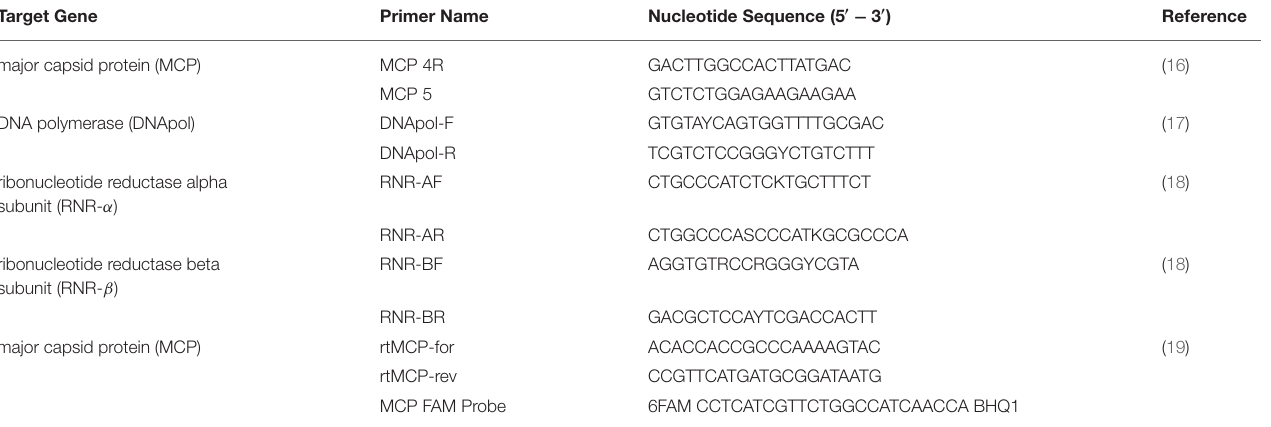
TABLE 1 | Primers used for molecular diagnosis and differentiation of ranavirus from amphibian samples in Chad,